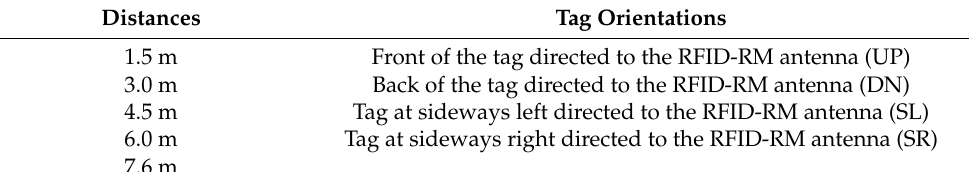
Figure 5. Tags positioned in an ( a ) upward orientation and ( b ) downward orientation (i.e., upper surface pointed away from reader).